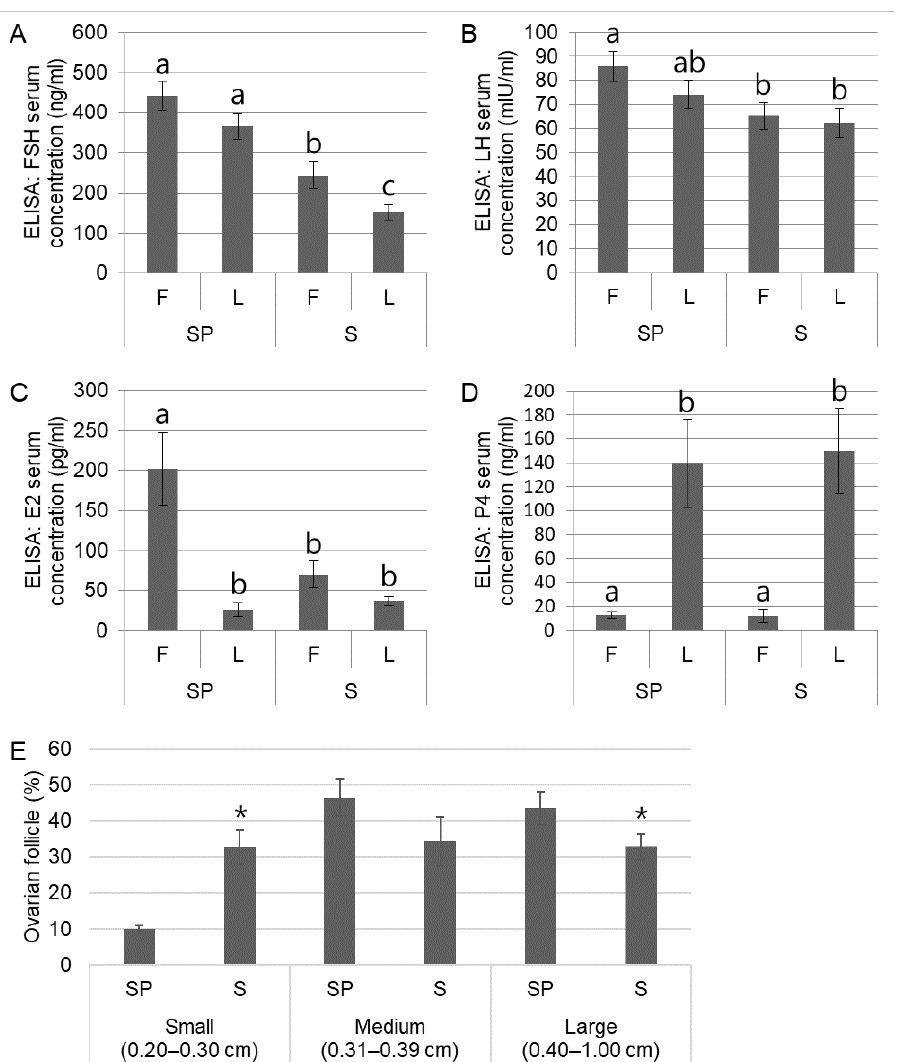
Figure 5. Changes in HPG axis function due to reduced kisspeptin expression. FSH and LH levels from the pituitary gland are significantly ( p < 0.05) reduced in the summer group ( A , B ). Significantly ( p < 0.05) lower E2 level is observed in the follicular phase of the summer group than in the counterpart ( C ). The pattern of the P4 level is not different between different seasons ( E ). Small or large follicles significantly ( p < 0.05) increased or decreased in the summer group than those in the spring group, respectively. The results by ELISA ( A – D ) are obtained from 50 domestic sows ( n in SP = 25 and n in S = 25). The values for classification of ovarian follicles ( E ) are from 34 animals under follicular phase ( n in SP = 17 and n in S = 17). Significant differences ( p < 0.05) among groups are indicated by different letters or superscripts * at the top of the bars. Graphs are presented as mean ± SEM. Abbreviations: FSH, follicle-stimulating hormone; LH, luteinizing hormone; E2, estradiol; P4, progesterone.